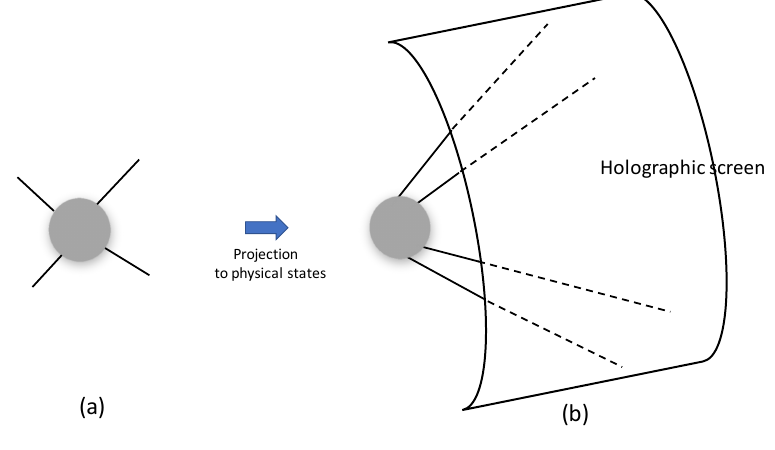
Figure 1. ( a ) Scattering of offshell states; ( b ) scattering of physical